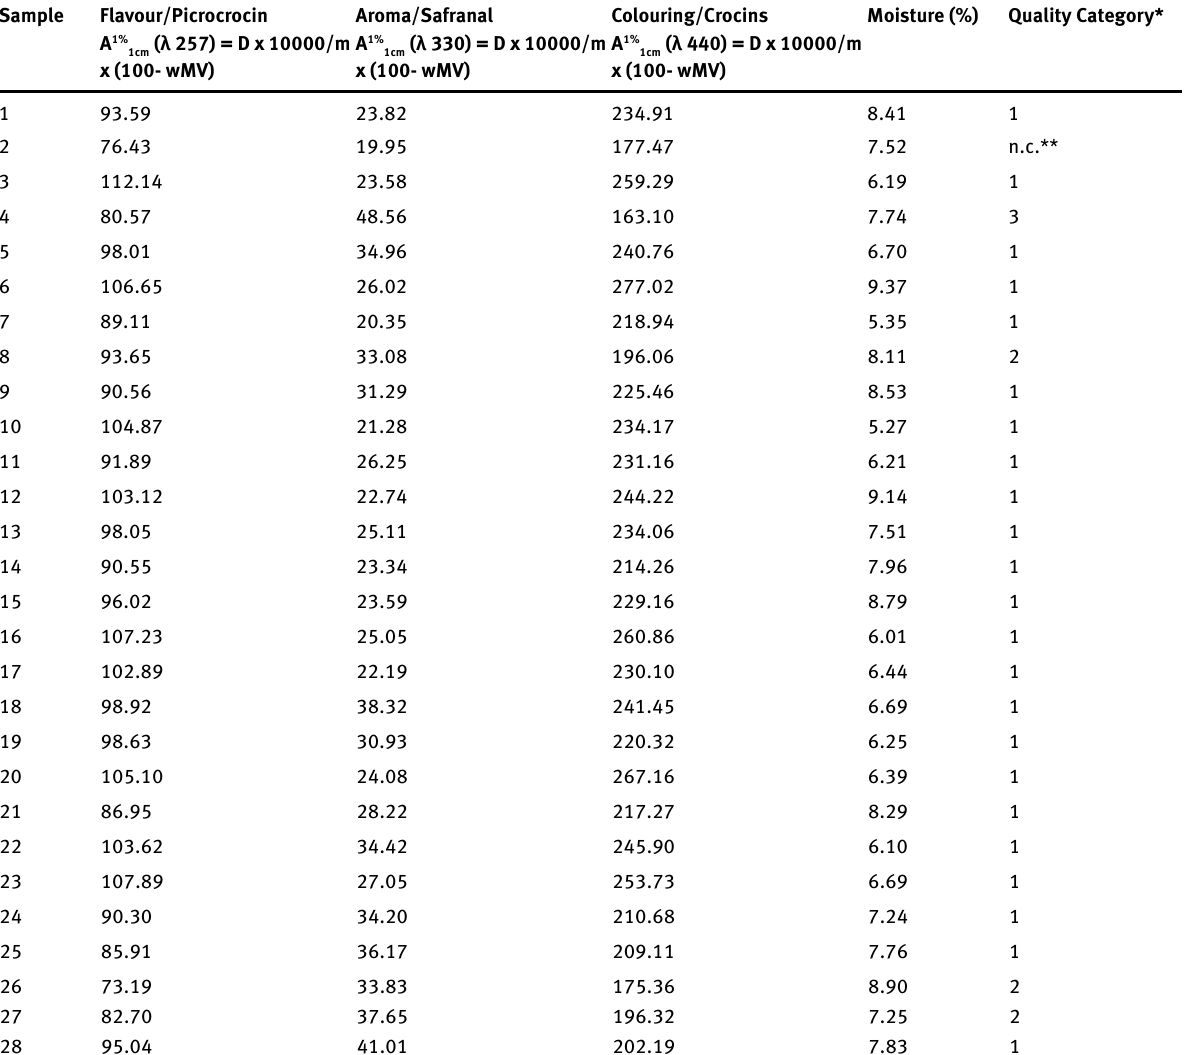
Table 2. Mean absorbance values for picrocrocin, safranal and crocins and moisture content of analyzed samples. Sample